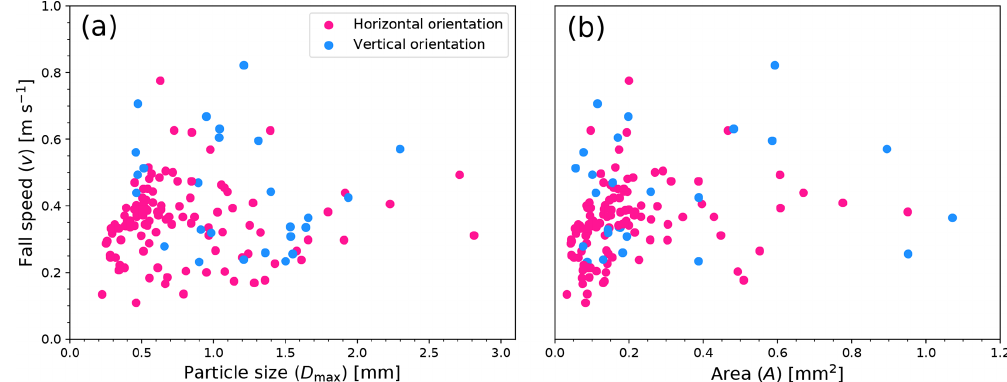
Figure 11. Fall speed vs. particle size ( v vs. D max ) and fall speed vs. cross-sectional area ( v vs. A ) for mixed particle shapes, elongated particles (shape group (1) Needles ), and planar particles (shape groups (5) Plates and (6) Stellar ), with horizontal and vertical orientation angles. (a) v vs. D max relationship. (b) v vs. A